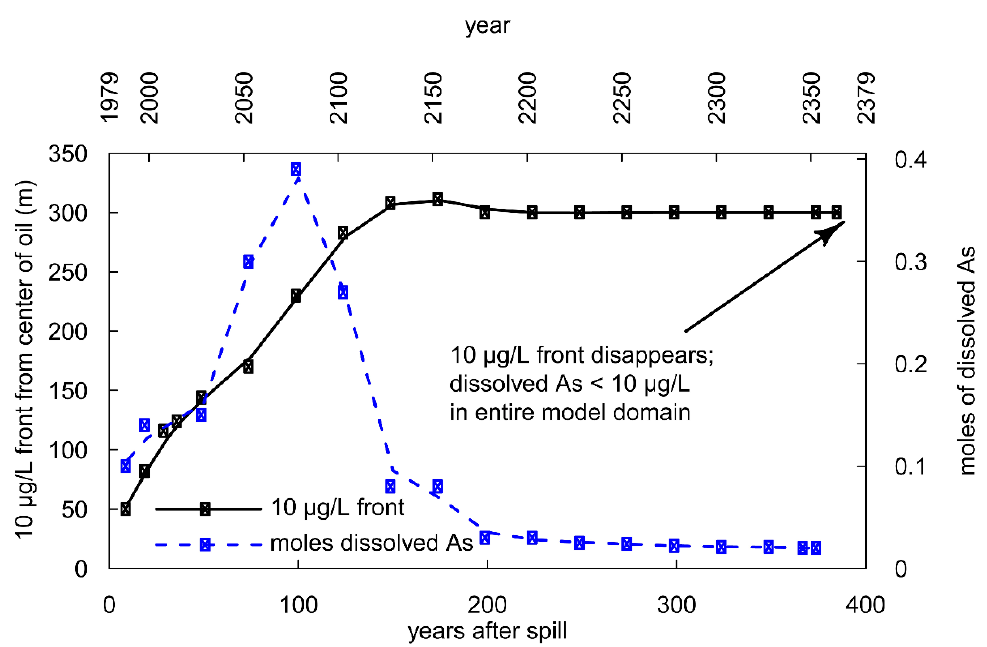
Figure 8. Simulation results for the location of the 10 µg/L front (black) and the total mass of dissolved As (blue) in the model domain over time.